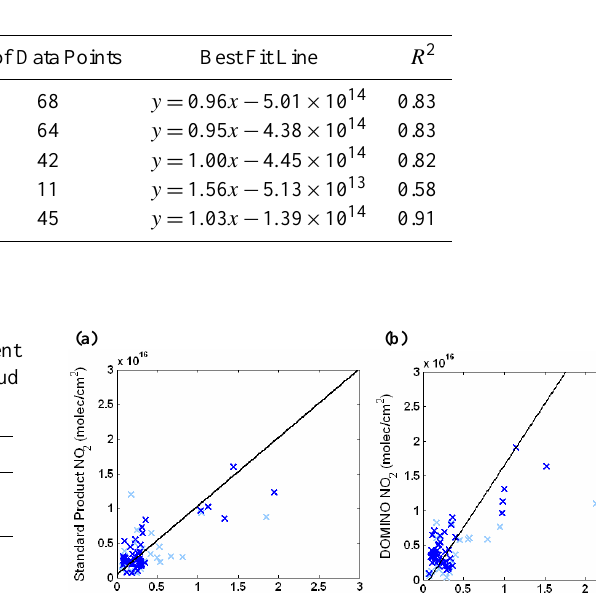
Table 2. The number of data points available, equation for best fit line, and correlation coefficient when OMI NO 2 derived using the BEHR product is filtered according to different cloud information.